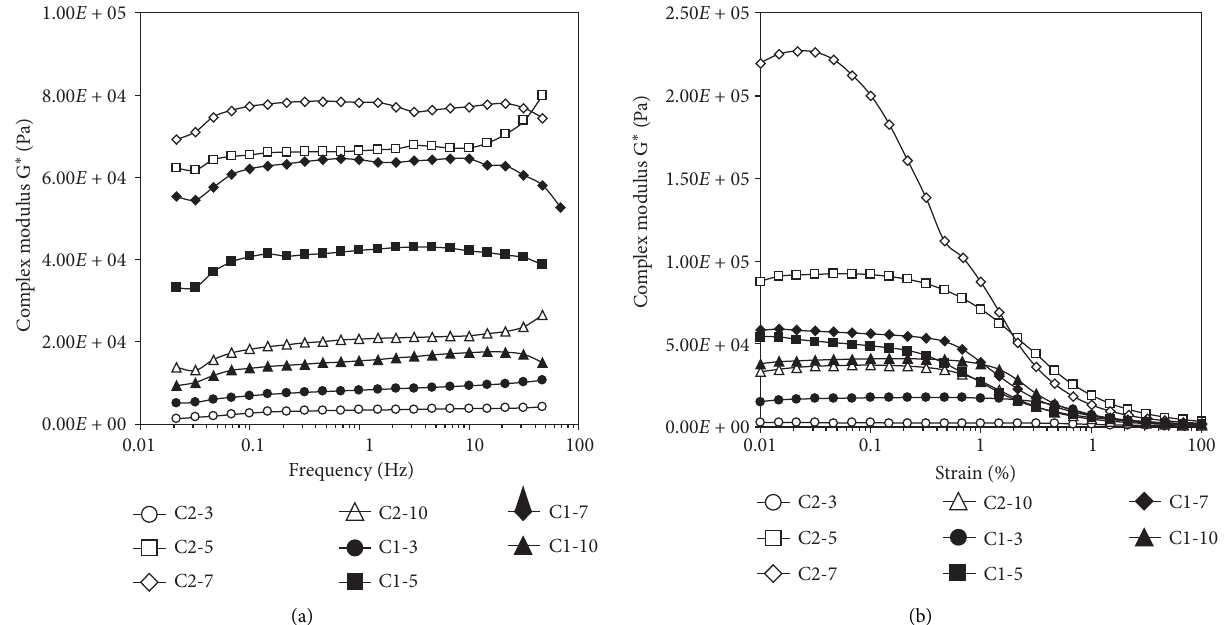
Figure 12: Complex modulus of the chitin hydrogels containing various LiCl concentrations as a function of (a) frequency from 0.01 to 100Hz and (b) strain from 0.01 to